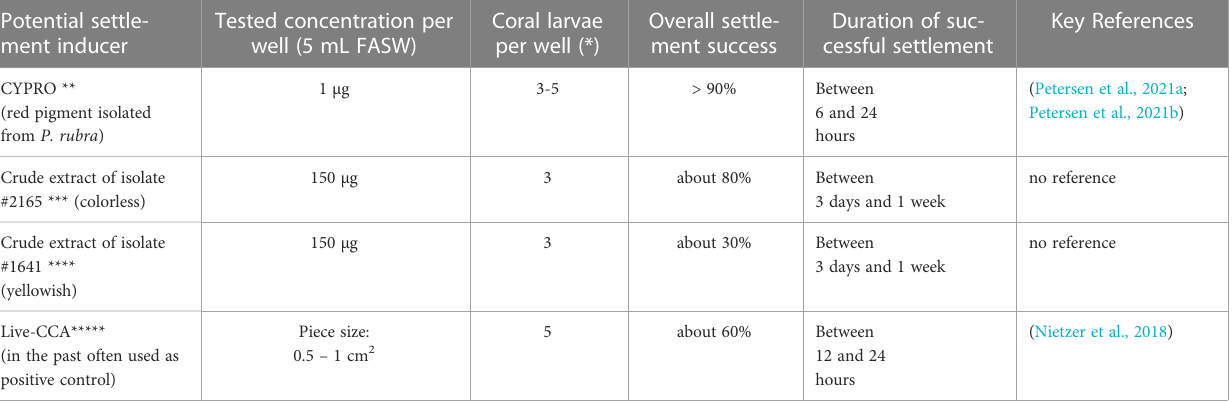
TABLE 1 Overview of successfully applied settlement